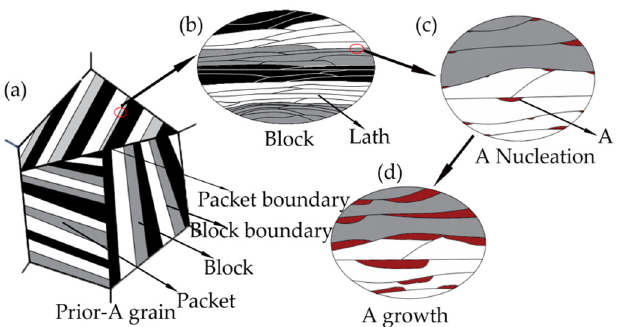
Figure 13. Schematic diagram of reversed austenite formation. ( a ) is a prior-austenite grain; ( b ) is block; ( c ) is reversed austenite nucleation at martensite lath boundary; ( d ) is reversed austenite growth.